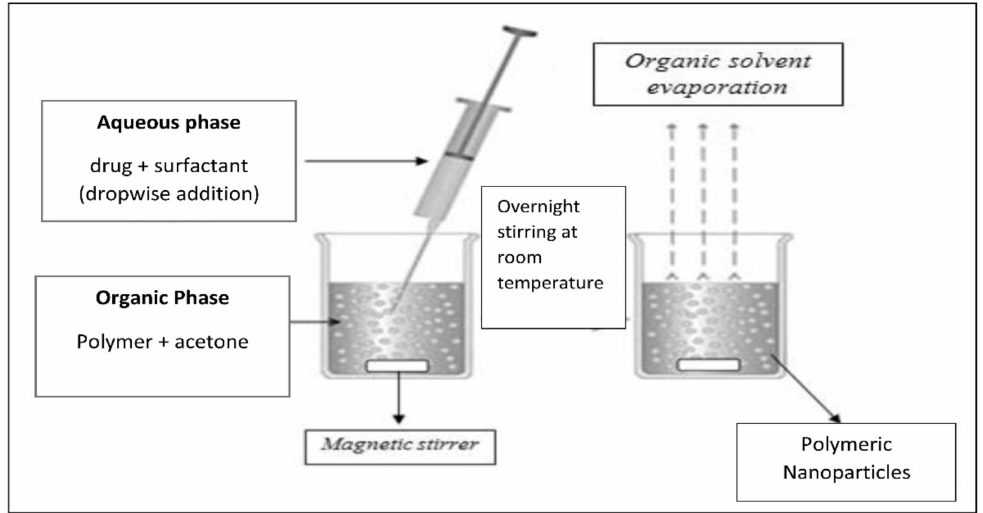
Figure 1. Formulation of doxycycline polymeric